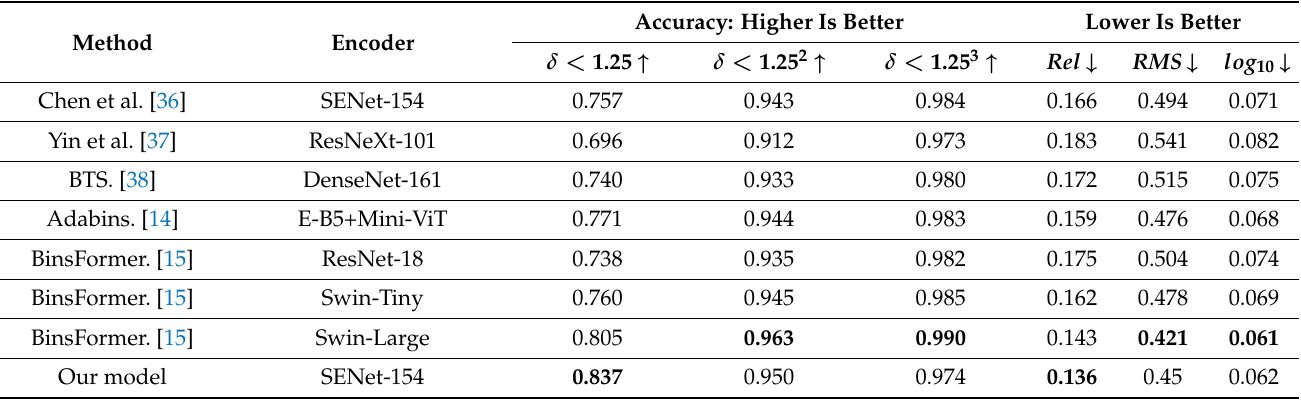
Table 4. Results of the model trained on the NYU-Depth-v2 dataset and tested on the SUN RGB-D dataset [29] without